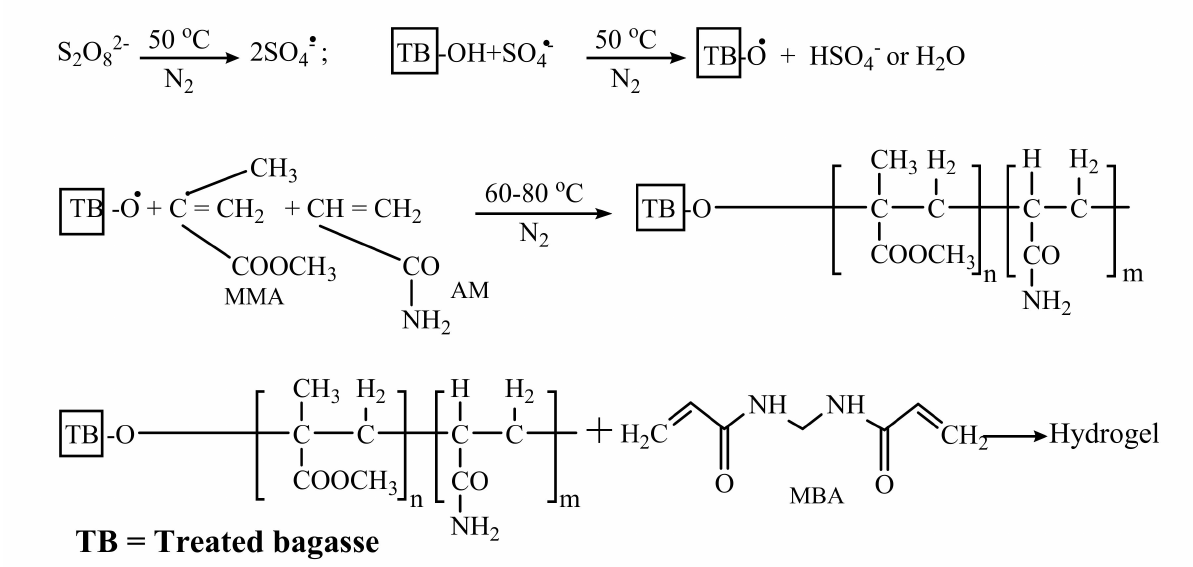
Figure 1. Reaction mechanism for the preparation of treated bagasse-based g-poly (AM-co-MMA) hydrogel